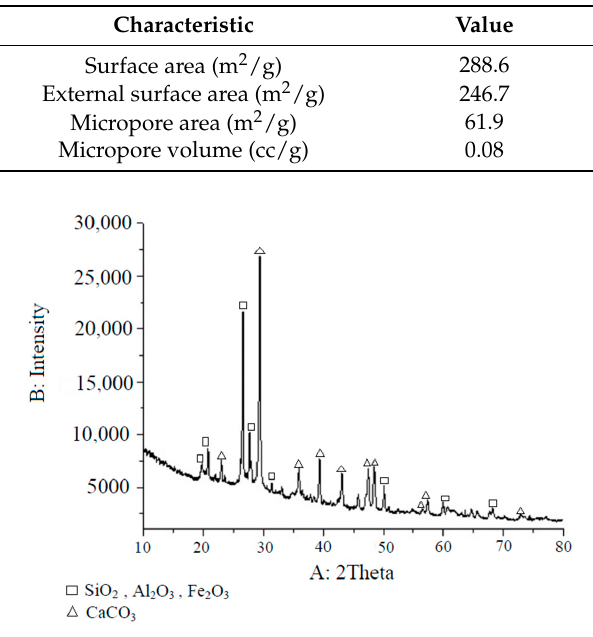
Figure 2. X-ray diffraction results of BAZLSC.